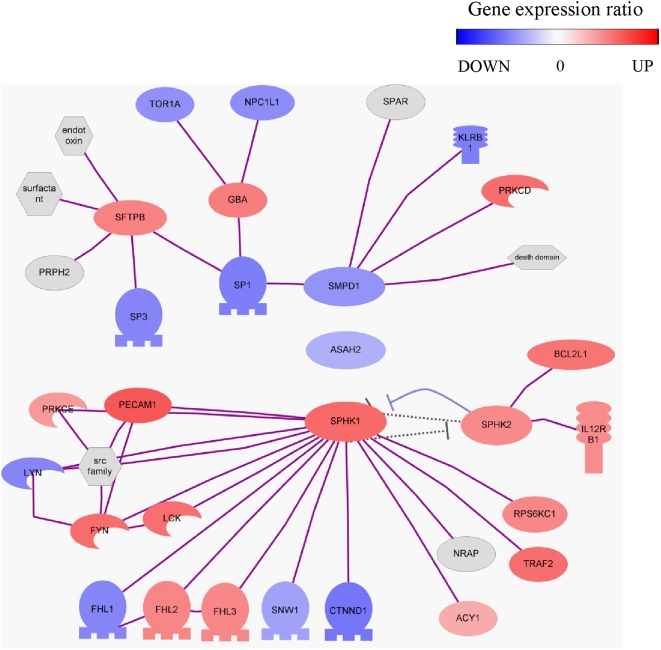
Analysis of genes of the sphyngolipid pathway in wt TG and CF-TG cells.Microarray data were collected, and the network of genes encoding enzymes involved in the sphyngolipid metabolism and predicted target genes that are significantly modulated was represented. Red color corresponded to up-regulated genes in CF-TG cells compared to wt TG cells and blue color to down-regulated genes.